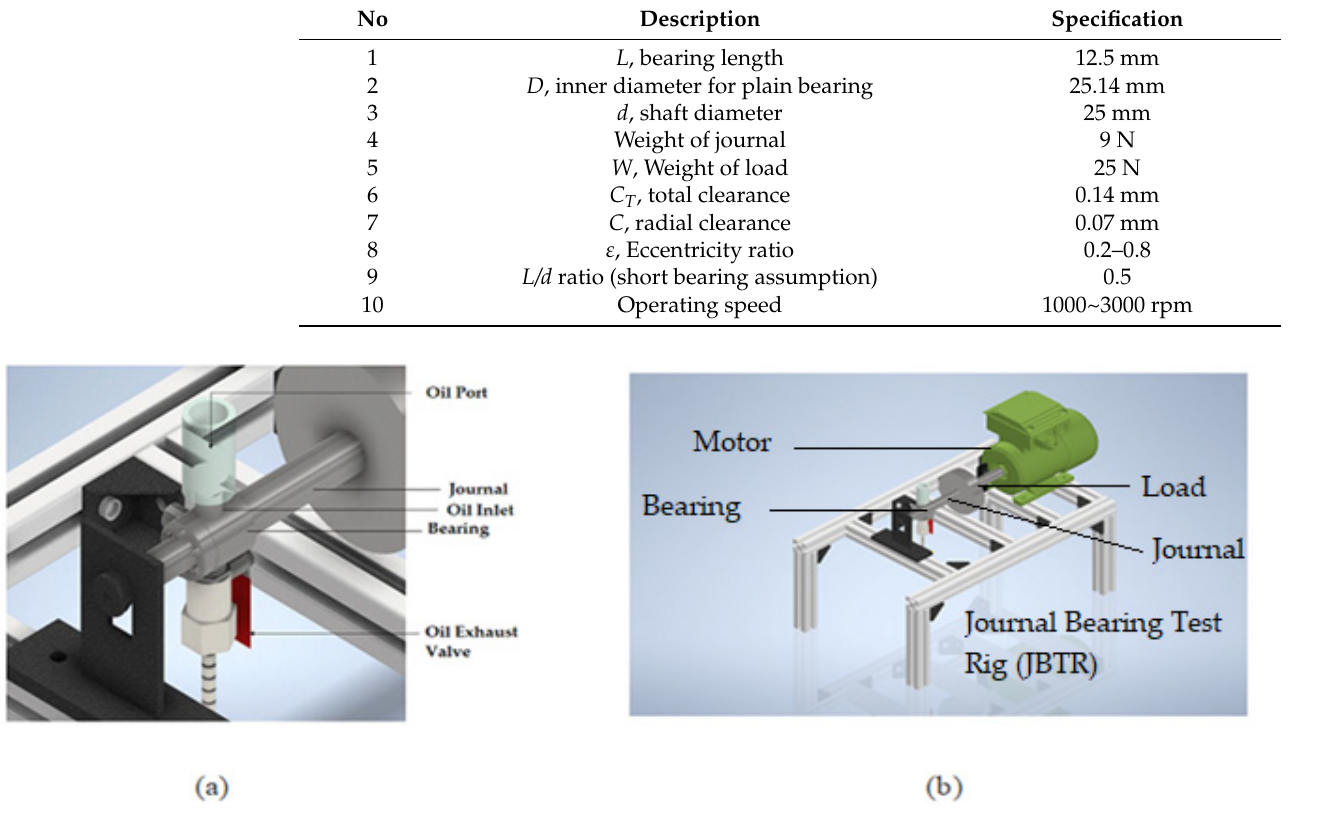
Figure 1. ( a ) Journal bearing schematic; ( b ) overall diagram of Journal Bearing Test Rig (JBTR).